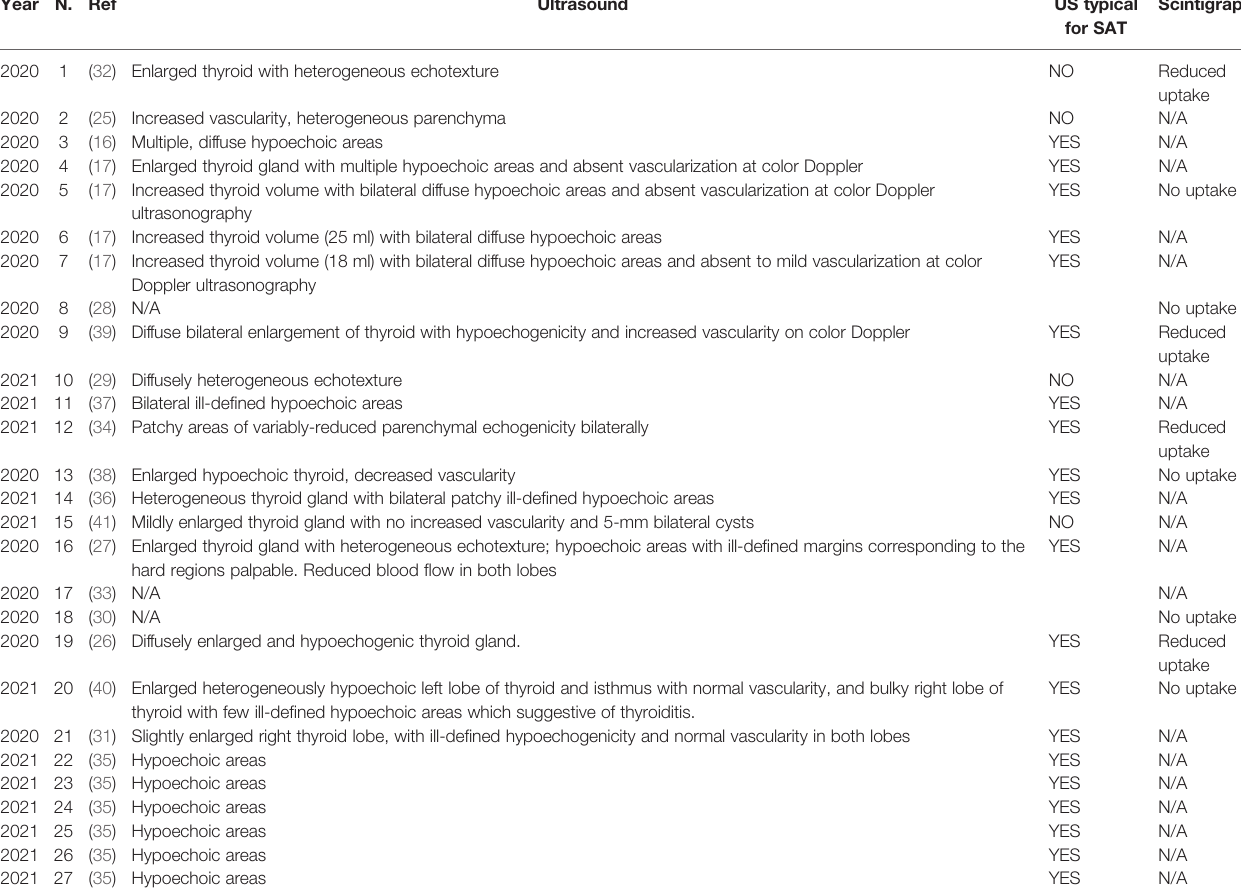
TABLE 3 | Results of thyroid-speci fi c imaging in the 27 included patients. Year N.